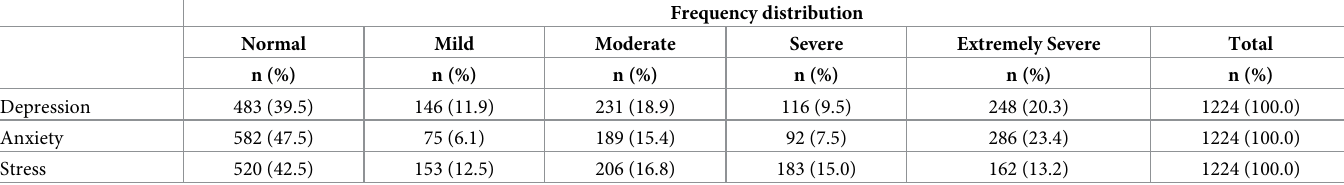
Table 3. Frequency distribution of depression, anxiety and stress levels in undergraduate students, Parana, Brazil,